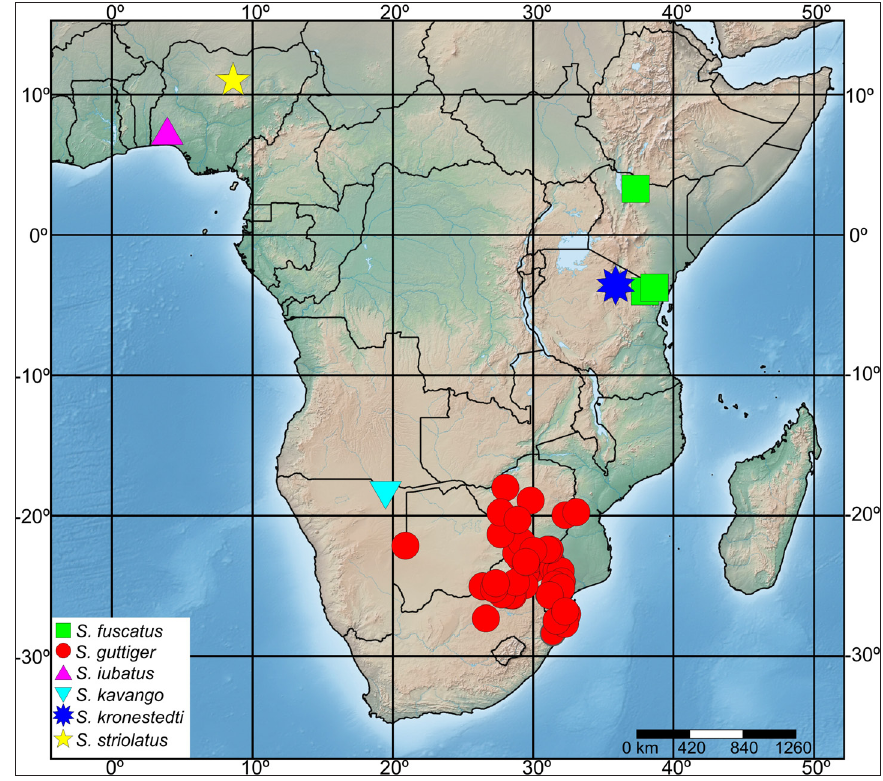
Fig. 512. Collecting localities of six African species of Stenaelurillus Simon,